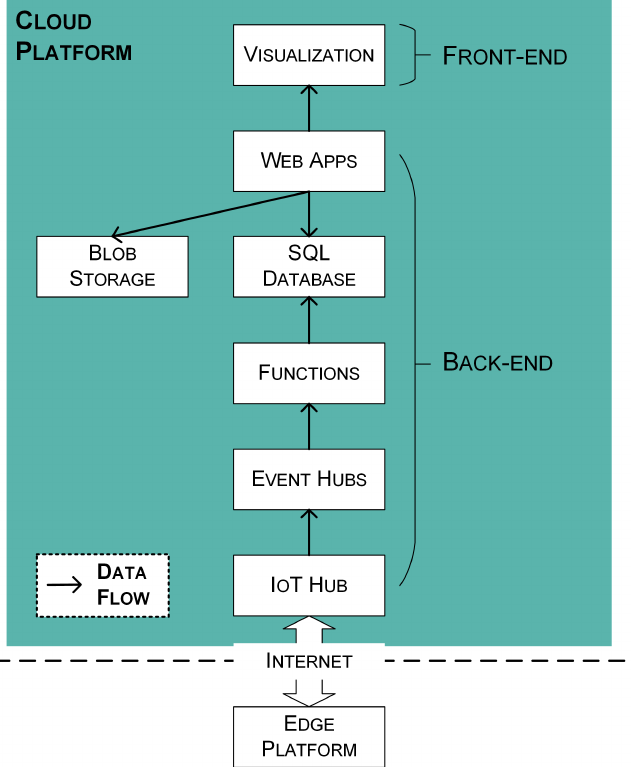
Figure 5. The service components used on the cloud platform and the data flow between the service